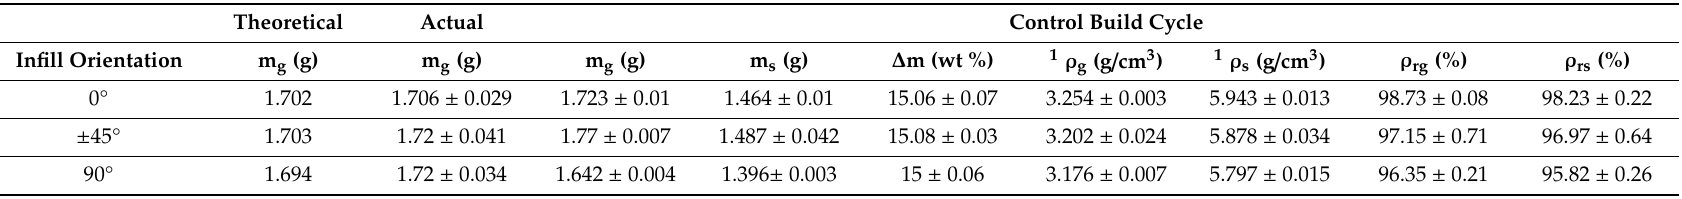
Table 1. Theoretical and actual green mass (m g ) for all the specimens produced with the di ff erent orientations and for the five parts of a control build cycle for each orientation: green (m g ) and sintered mass (m s ), mass loss ( ∆ m), green ( ρ g ) and sintered ( ρ s ) apparent density, and relative green ( ρ rg ) and sintered ( ρ rs ) density. The average and standard deviation values are provided for all the parameters.